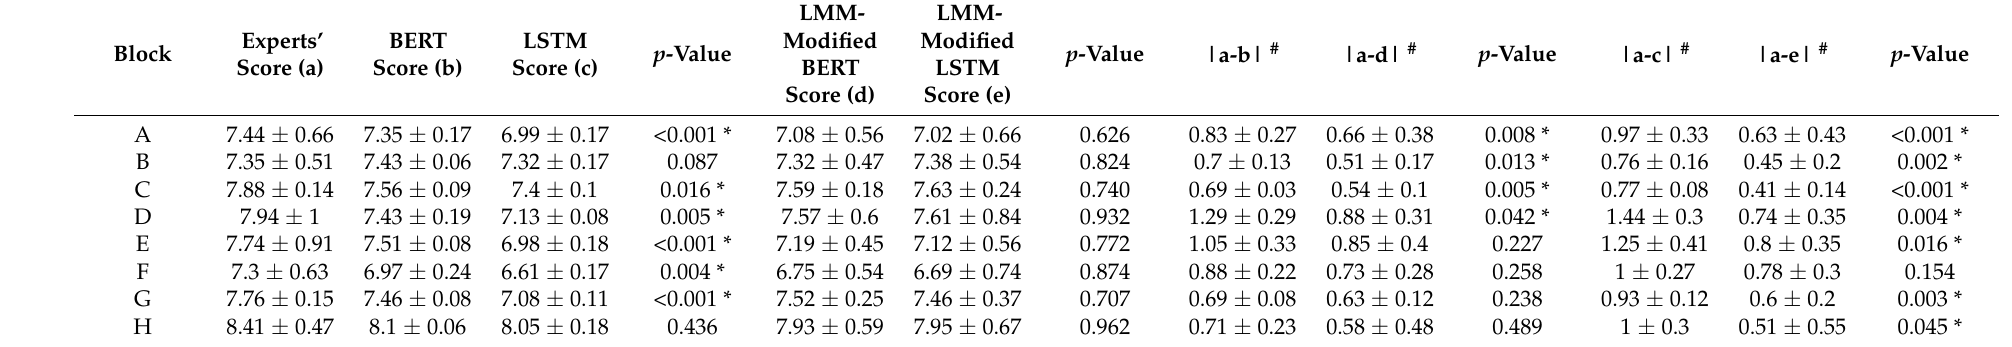
Table 4. Experts’ scores, BERT and LSTM prediction scores, and MAE of different